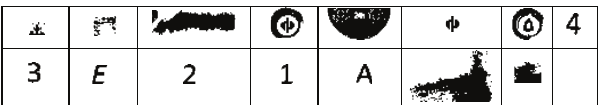
Figure 20: Extracted button